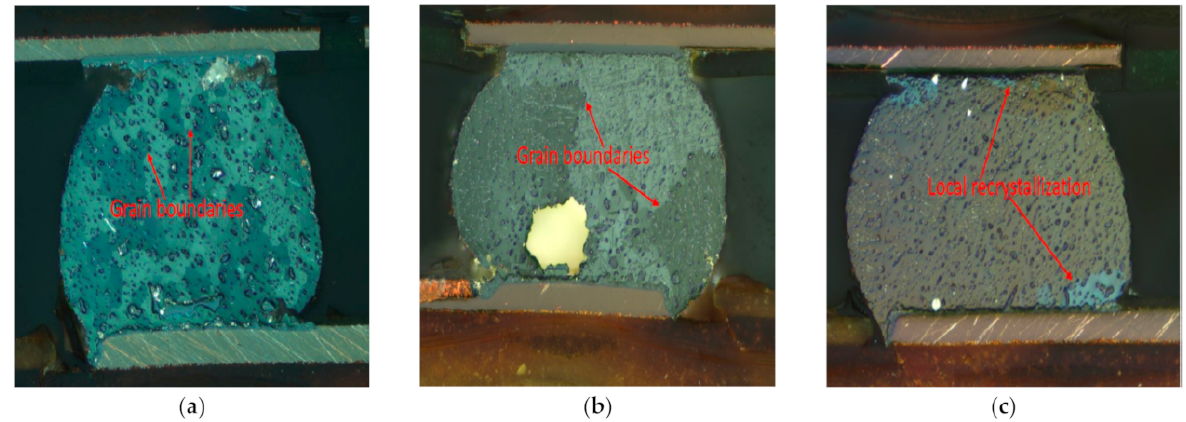
Figure 17. Polarized cross-section images of different alloys; ( a ) SAC-In; ( b ) SAC-Bi; and ( c ) Innolot